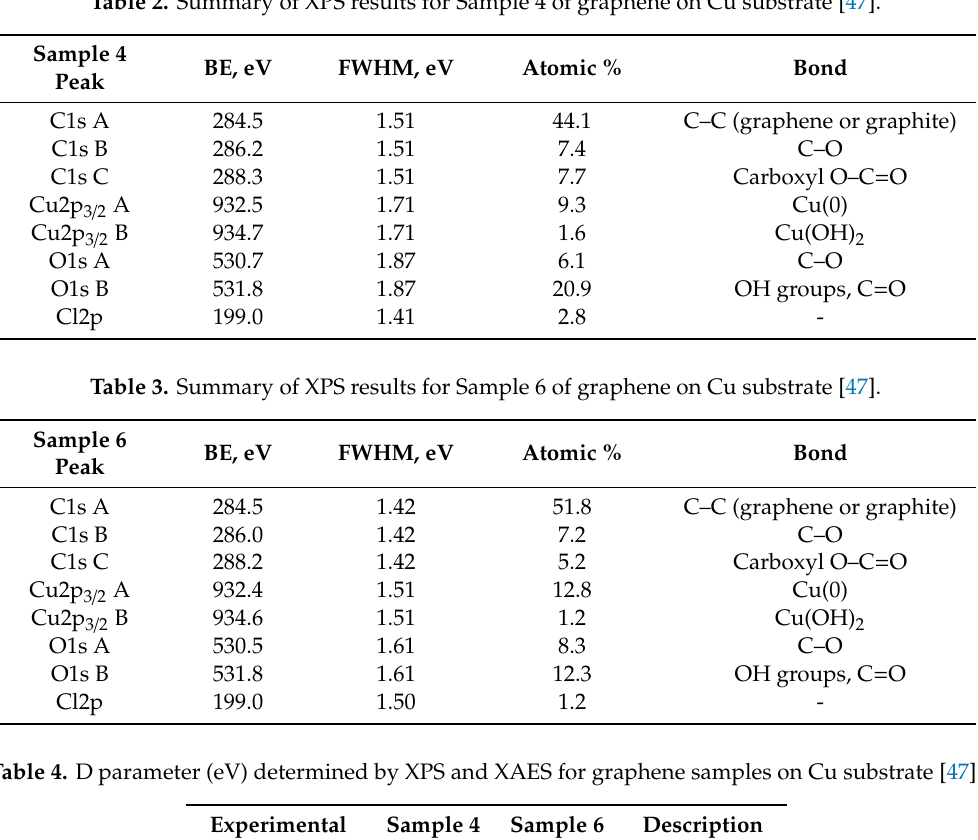
Table 2. Summary of XPS results for Sample 4 of graphene on Cu substrate [47].